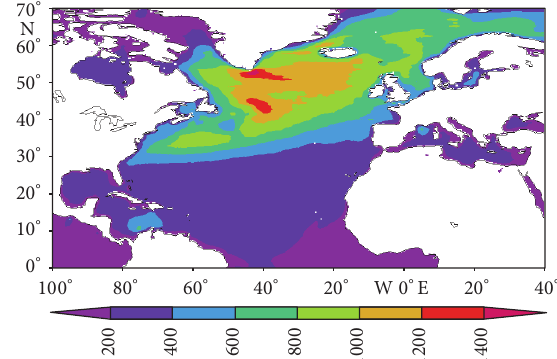
Figure 2: Annual average wind power density in the North Atlantic, unit: W/m 2